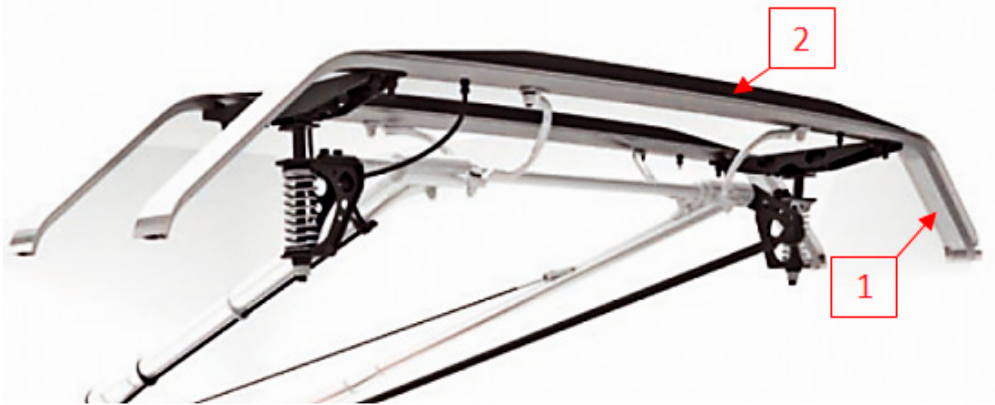
Figure 1. Conventional design of pantograph’s panhead: 1—panhead body (6060 aluminum alloy); 2—contact strips (graphite composite).